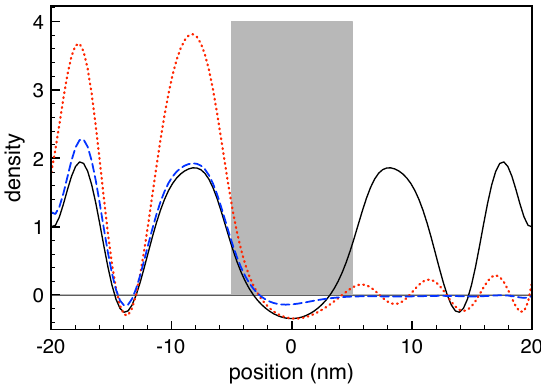
Figure 8. Room-temperature spatial carrier density (in units of its barrier-free value) corresponding to a GaAs-based rectangular-barrier profile (device length l = 40nm, barrier width w = 10nm, and barrier height V 0 = 150meV) in the presence of a monoenergetic injection from the left ( (cid:101) 0 = 50meV). Here, ∞ ) density profile (solid curve) is compared to the results corresponding to the coherent-limit ( τ → two different values of the relaxation time: τ = 5ps (dashed curve) and τ = 50fs (dash-dotted curve). Readapted from